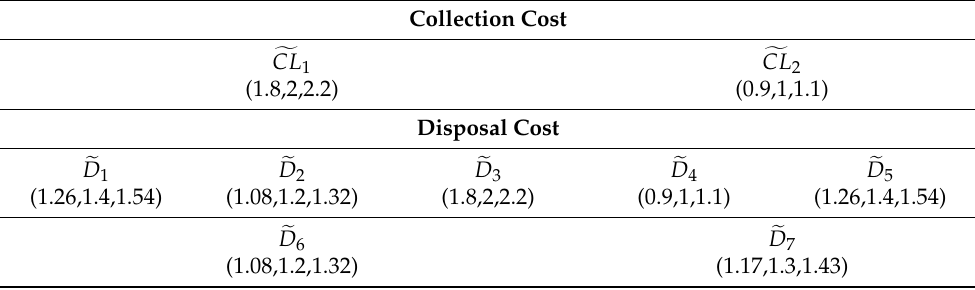
Table 8. Collection and disposal costs per unit (us dollar).